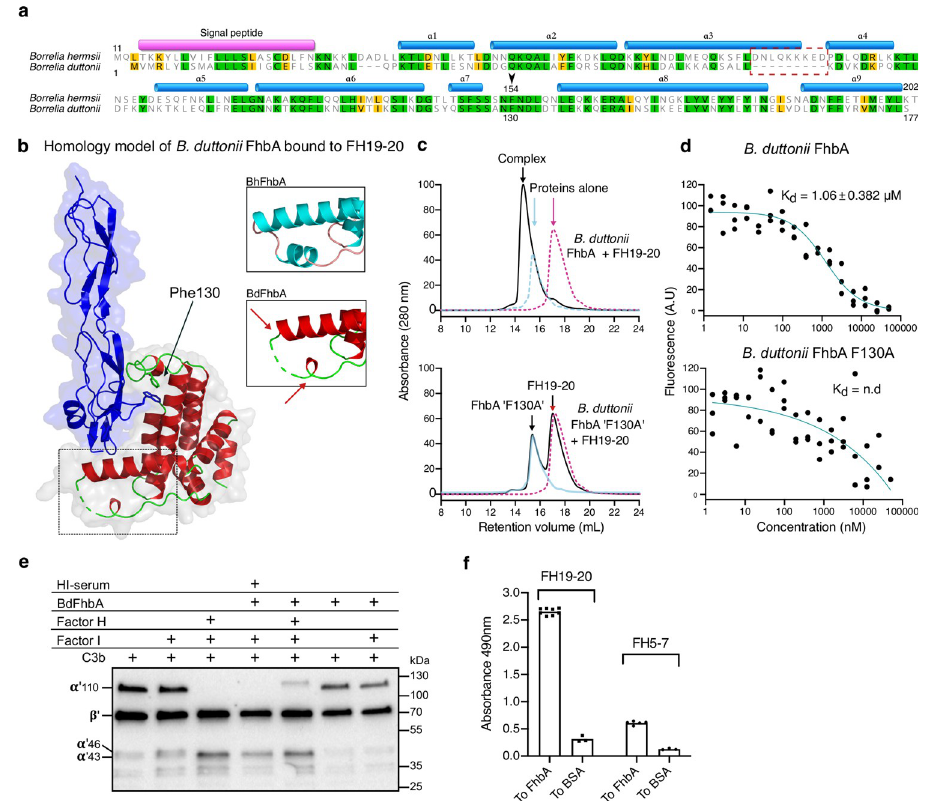
helices 3 and 4 (dashed red rectangle). (b) Structure-based homology model of BdFhbA shows almost identical overall structure to BhFhbA except shortening of helices 3 and 4. (c) Elution profiles of the proteins alone and in combination with each other on the size exclusion column. FH19-20 protein elution profile in magenta, wild type and Phe130A variant BdFhbA in light blue, and a combination of the two proteins in black curves. In each chromatography run, 100 μ l of sample containing 20 nmole of each of the tested protein(s) was injected. (d) Binding of FH19-20 to BdFhbA and BdFhbA/Phe130A variant as detected by MST. K d -values with SEM ( μ M) calculated from three technical replicates (normalized fluorescence values) are shown for the wild type BdFhbA. For the BdFhbA/Phe130A variant, the MST software could not reliably determine a value for K d . (e) Cofactor activity of FH in factor I mediated cleavage of C3b. FH from serum or after purification was bound to BdFhbA coated on microwell plate. After washing, C3b and/or Factor I were added. C3b and its cleavage fragments ( α ’46 and α ’43) were detected using anti-C3d antibody. (f) Binding of FH19-20 and FH5-7 to surface coated BdFhbA. Individual data points from ELISA are shown, and the bars represent mean